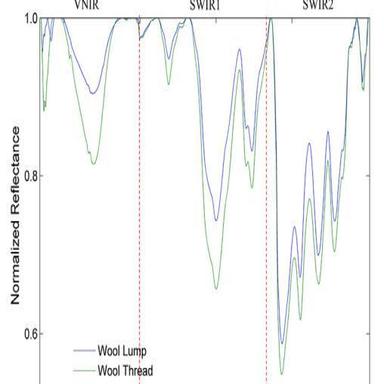
Spectral comparison between textile samples with different physical properties. (the 1st column: reflectance spectra; the 2nd column: CR spectra).